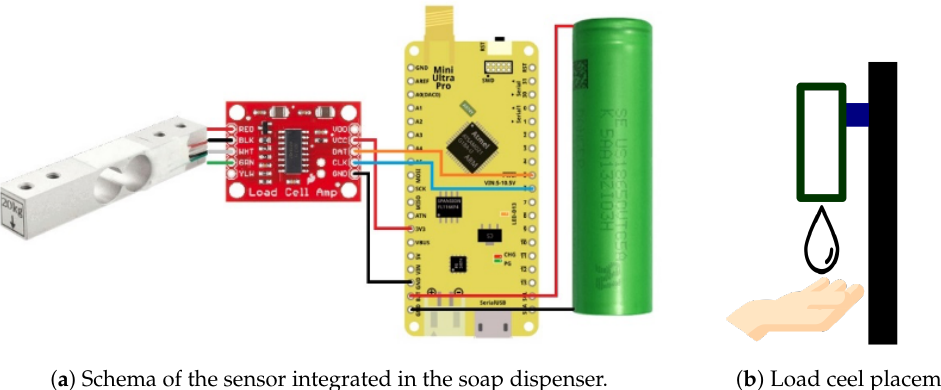
Figure 6. Soap dispenser